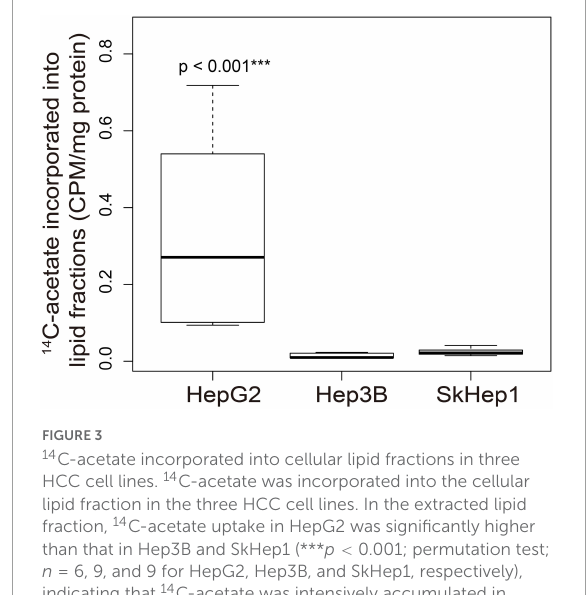
FIGURE3 14 C-acetate incorporated into cellular lipid fractions in three HCC cell lines. 14 C-acetate was incorporated into the cellular lipid fraction in the three HCC cell lines. In the extracted lipid fraction, 14 C-acetate uptake in HepG2 was significantly higher than that in Hep3B and SkHep1 (*** p < 0.001; permutation test; n = 6, 9, and 9 for HepG2, Hep3B, and SkHep1, respectively), indicating that 14 C-acetate was intensively accumulated in HepG2 cells and subsequently incorporated into cellular lipid fractions. 14 C-acetate uptake ( β counter) in cells normalized by protein weight (CPM/mg protein). We summarized the measurements as box-plots that label 25, 50, and 75% quantiles in the boxes with whiskers presenting at most 1.5 × interquartile